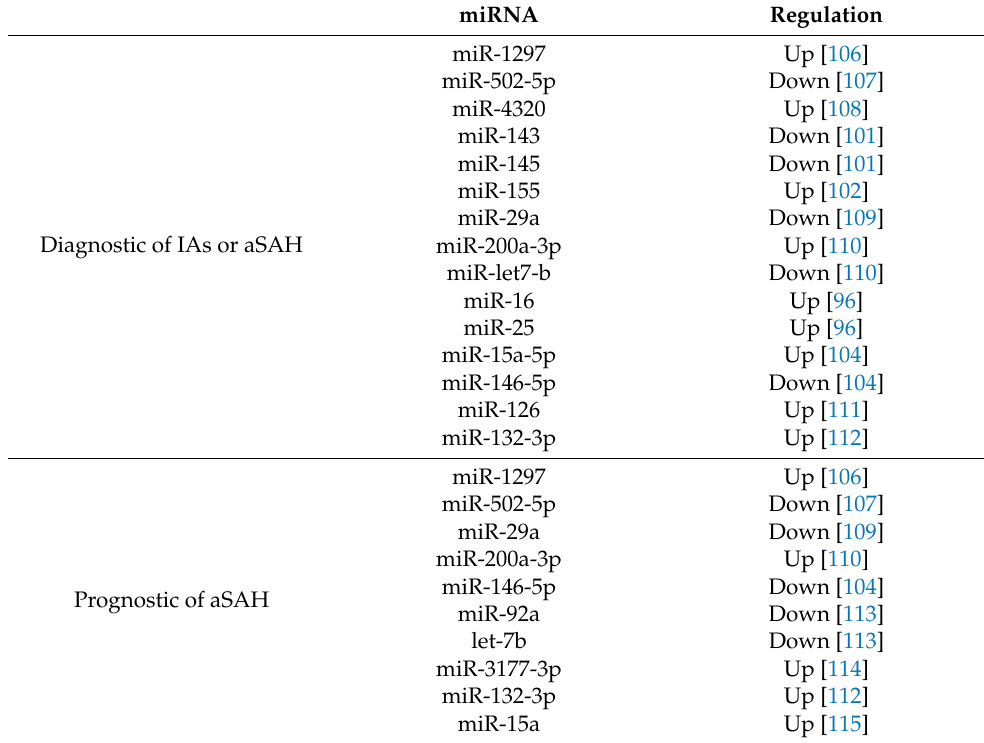
Table 4. Circulating miRNAs as biomarkers in IA and